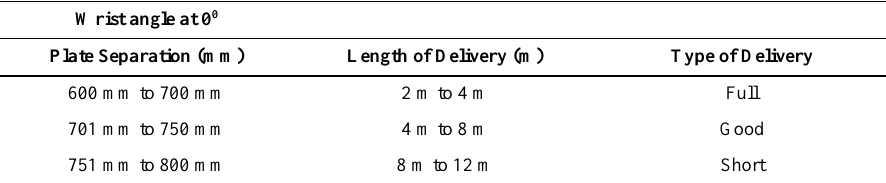
Table 3. Showing data used in test with